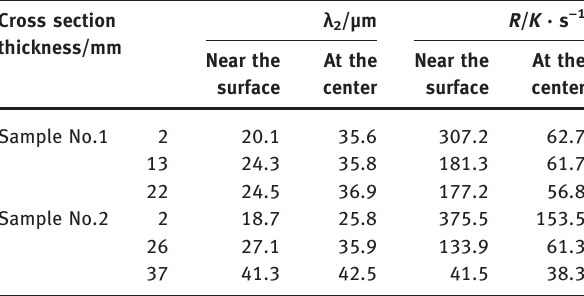
Table 2: Measured average λ 2 and calculated R of VMC samples. Cross